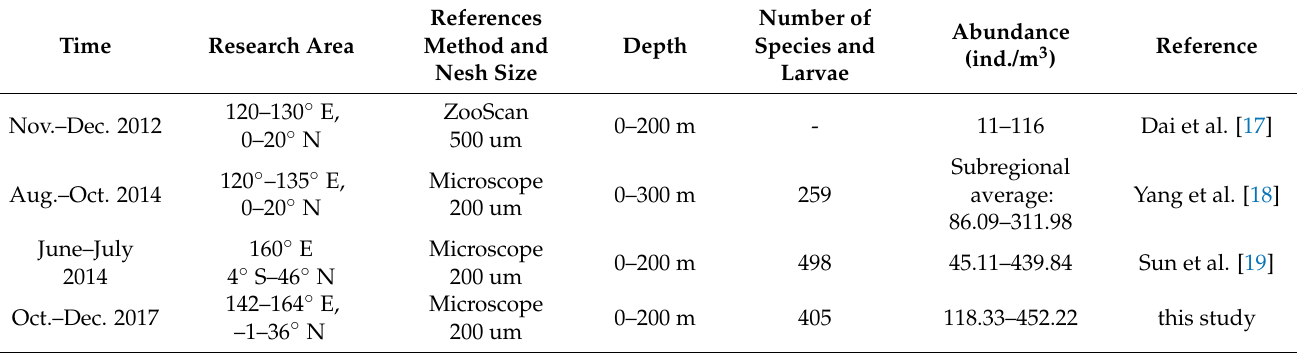
Table 3. The comparison of zooplankton with the historical